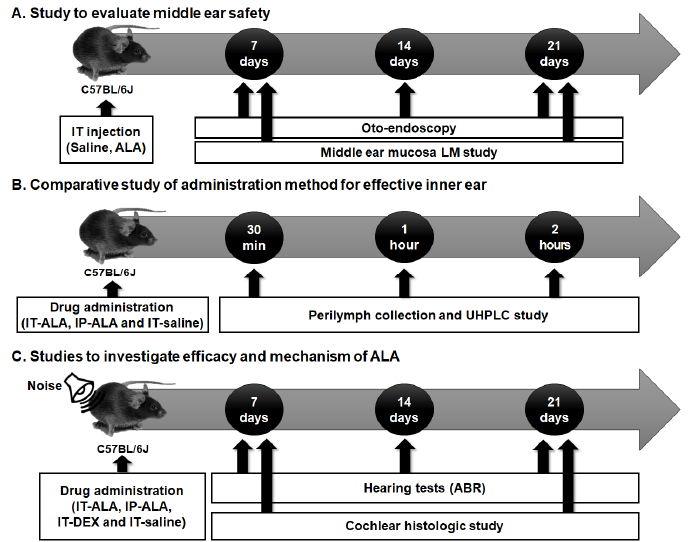
Figure 1. The experimental design scheme. ( A ) The middle ear safety after IT drug administration was investigated using otoendoscopy and middle ear mucosal studies. ( B ) The concentration of ALA in the sampled perilymph was measured according to the administration methods. ( C ) The therapeutic effect of ALA was assessed using histologic studies and hearing tests in the mouse model of NIHL. IT, intratympanic; ALA, alpha ‐ lipoic acid; LM, light microscopic; UHPCL, ultra ‐ high performance liquid chromatography; ABR, auditory brainstem response; NIHL, noise ‐ induced hearing